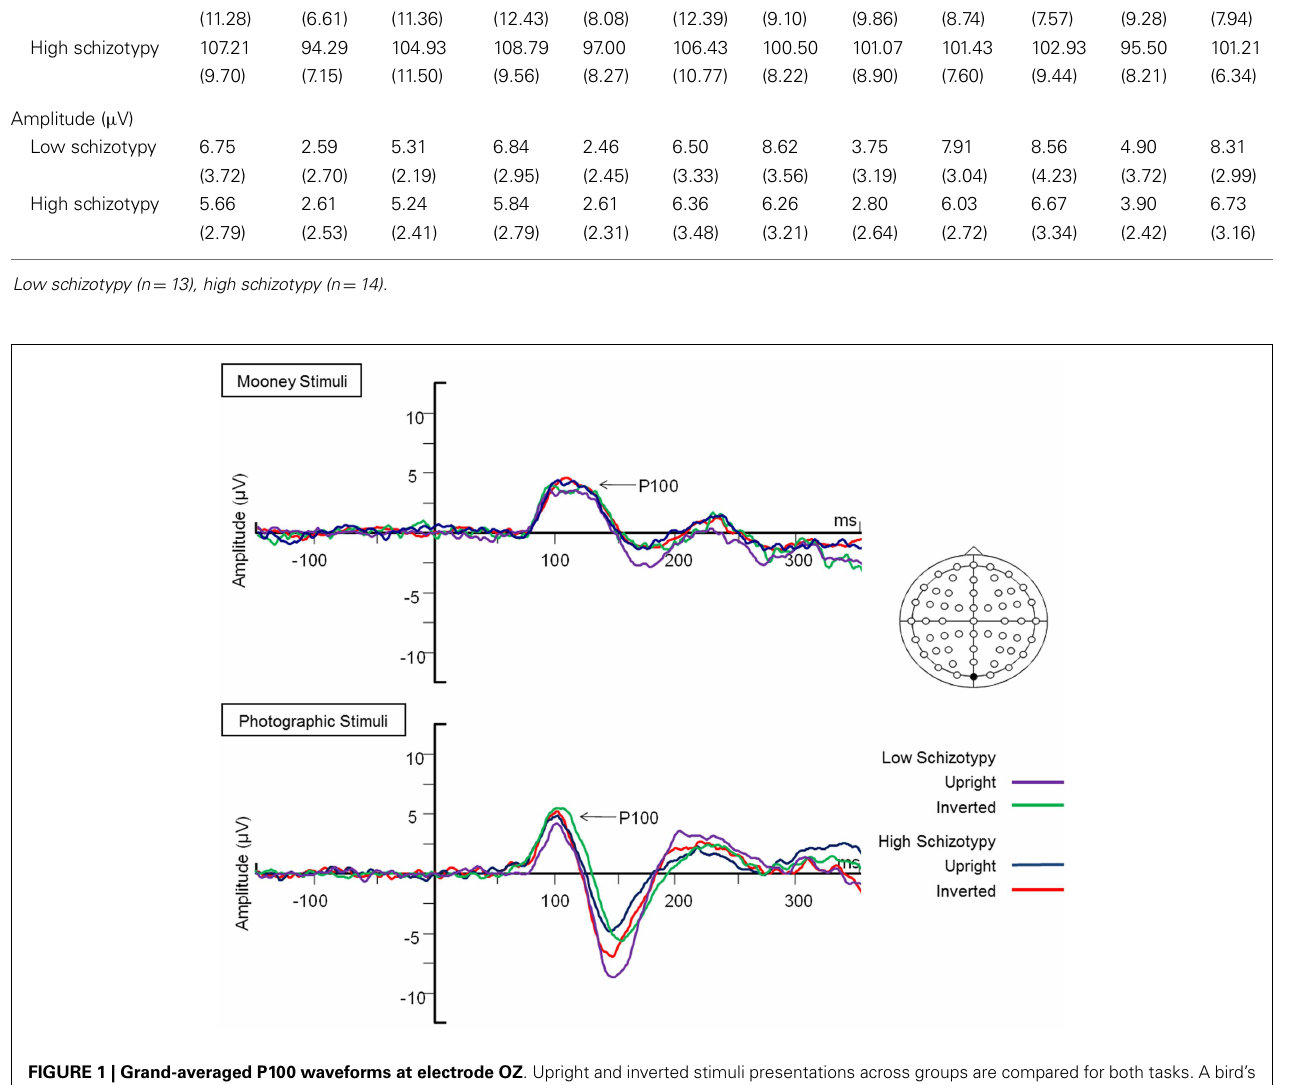
effect was reversed for inverted faces where earlier latencies were shown in the right hemisphere ( M = 165.20 ms,SD = 9.38) versus interaction was shown. The low schizotypy group had ear- lier latencies for upright relative to inverted faces;